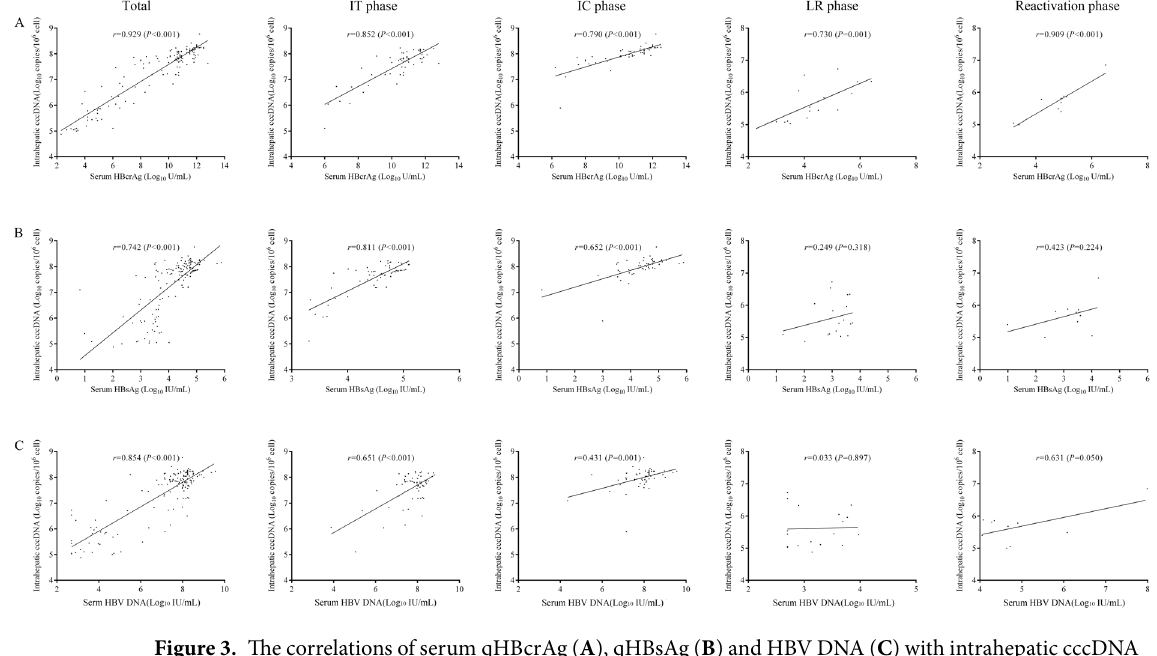
Figure 3. The correlations of serum qHBcrAg ( A ), qHBsAg ( B ) and HBV DNA ( C ) with intrahepatic cccDNA among different phases of CHB.